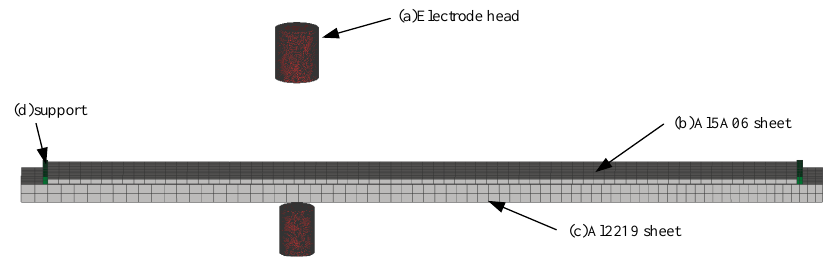
Figure 6. 5A06/2219 finite element model.